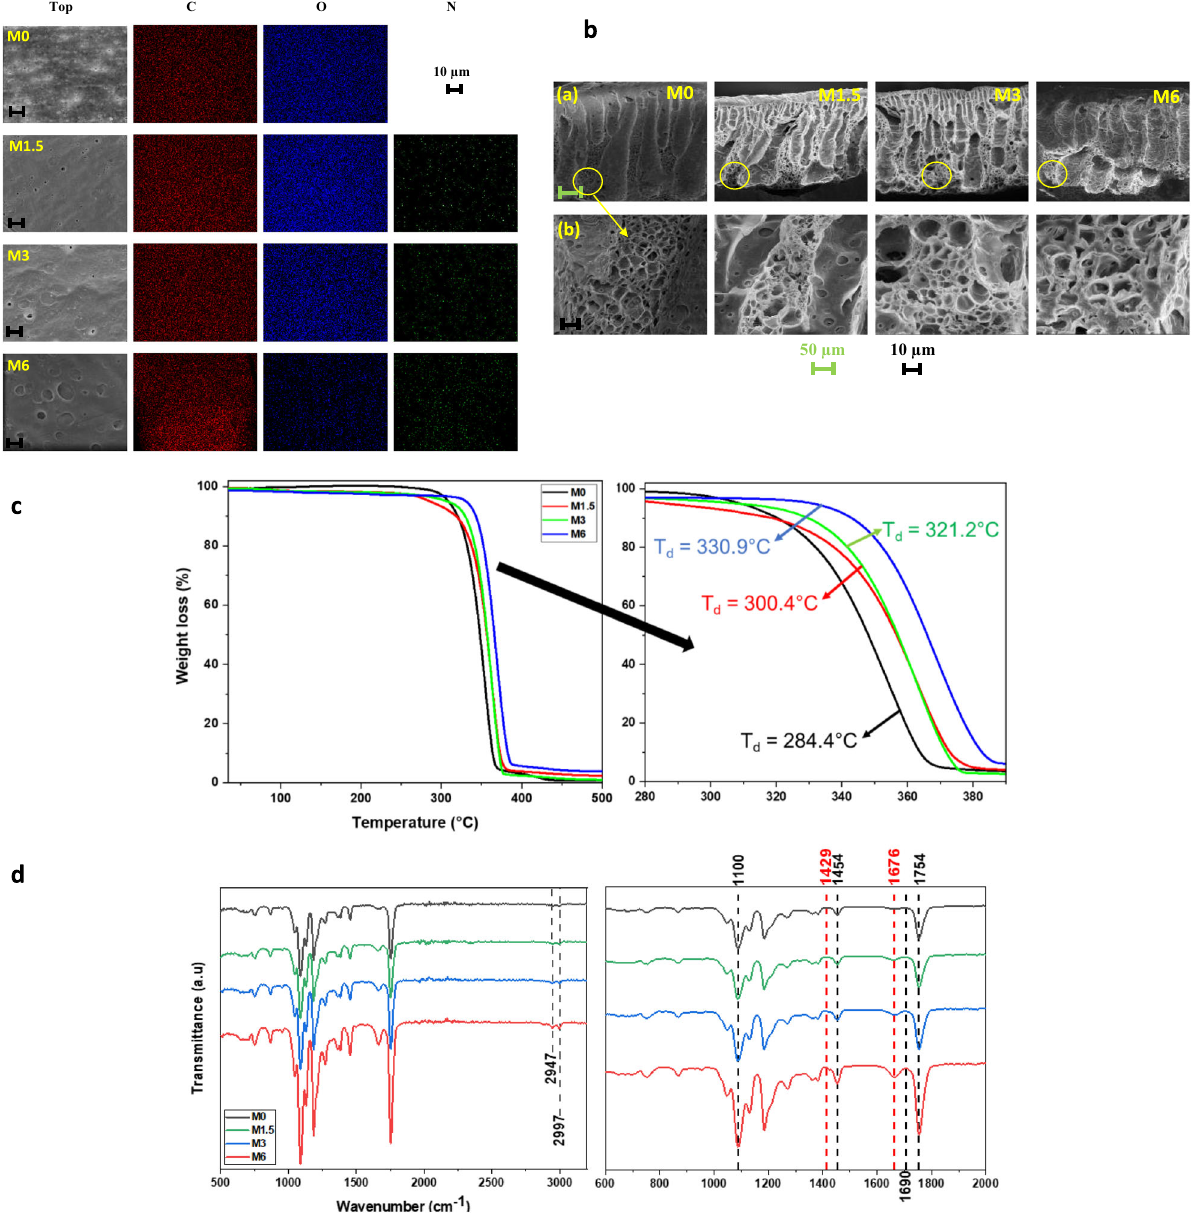
Fig. 2 Nanocomposite membranes characterization. a SEM images and EDS elemental mapping of the pristine and nanocomposite membranes. b Cross-sectional and magni fi ed SEM images of the pristine and nanocomposite membranes. c TGA curves of the pristine and nanocomposite membranes. d FTIR spectrum of pristine and nanocomposite